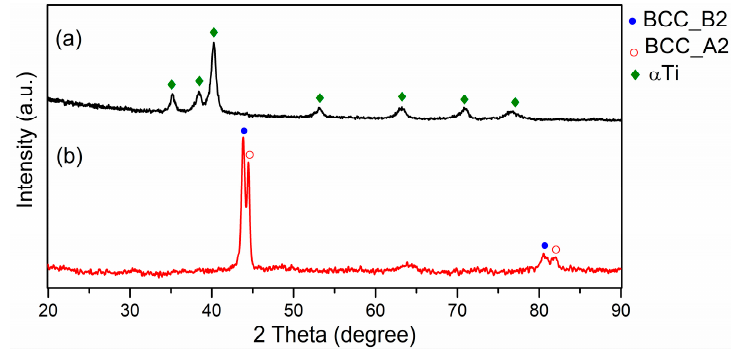
Figure 2. X-ray diffraction (XRD) pattern of the ( a ) Ti6Al4V substrate and ( b ) as-deposited AlCoCrFeNiTi 0.5